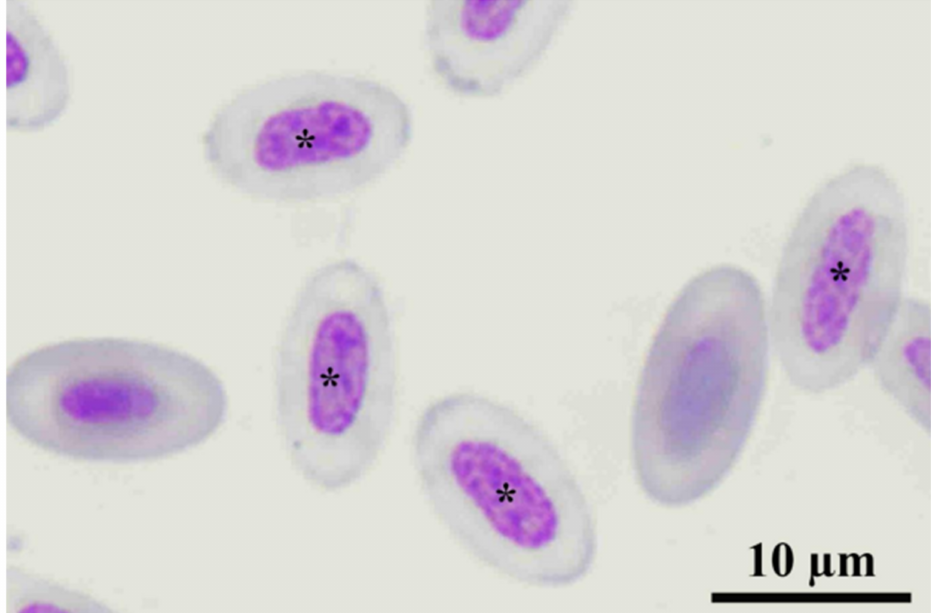
Figure 1. Hypochromic erythrocytes (*) found in rufous-winged buzzard with PCV 0.18 L/L and negative for blood parasites. Note , it is not clear if the 2 non-labeled erythrocytes are normochromic or polychromatophilic